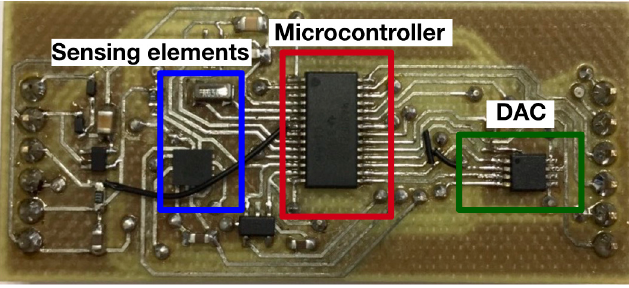
Figure 4. Developed Printed Circuit Board (PCB).